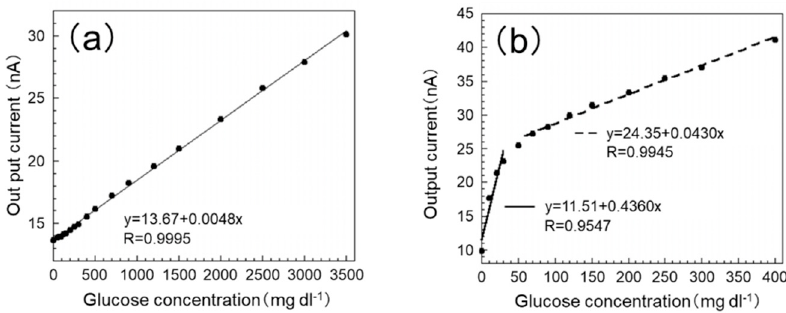
Figure 4. Calibration curve of the biosensor in PB. ( a ) Self-assembled monolayer/glucose oxidase enzyme (SAM/GOx) sensor; ( b ) The previous sensor assay conditions were as follows: temperature 30 °C and pH 7.8. Each sample was measured 10 min after the output current became stable. The black dots represent the relationship between the concentration of the glucose and the output current.